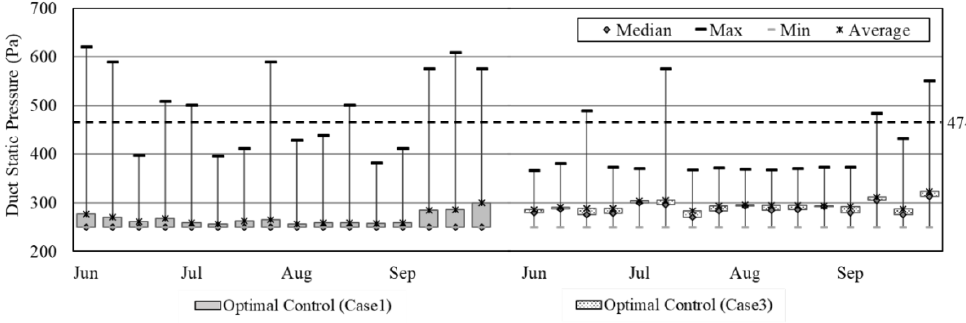
Figure 5. Duct static pressure changes during optimal control mode for June through September.